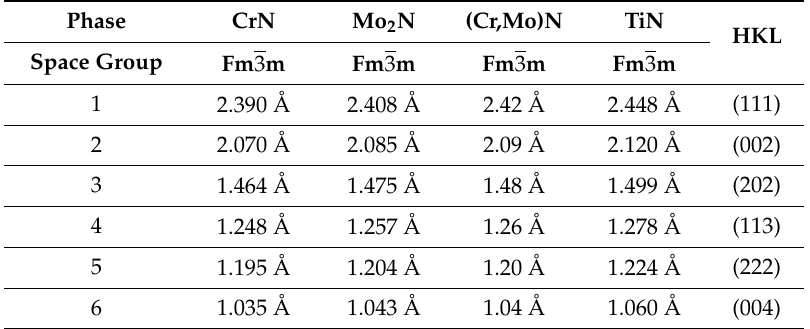
Figure 1. ( a – c ) structure and ( d ) chemical composition of the microdroplet in the Ti–TiN–(Ti,Cr,Mo,Al)N coating (TEM), selected area electron diffraction (SAED) pattern for area A ( e ) and area B ( f ). The microdroplet core is surrounded by area I (crystal sizes are 3–5 nm), then by area II (crystal sizes are 8–15 nm), and then by area III (crystal sizes are 20–40 nm). Table 3. Values of the interplanar spacings d (for the first six HKL indices) for nitrides, forming the Table 2. Coe ffi cients of thermal conductivity of metals depending on temperature, W ⁄ (m × K) [77]. Ti–TiN–(Ti,Cr,Mo,Al)N